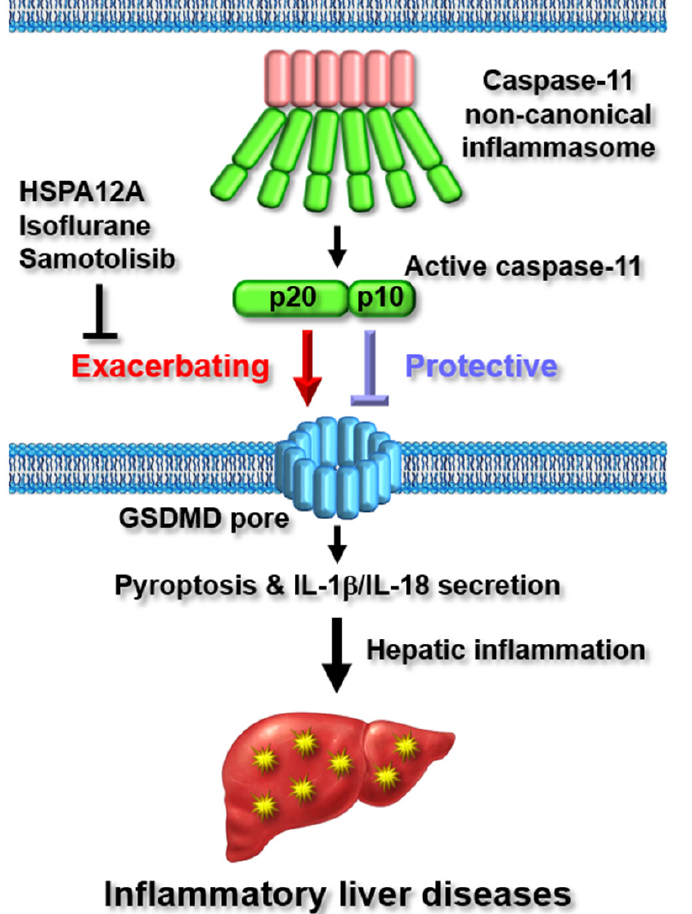
Figure 3. Graphical summary depicting the regulatory roles of the caspase-11 non-canonical inflam- masome in inflammatory liver diseases.